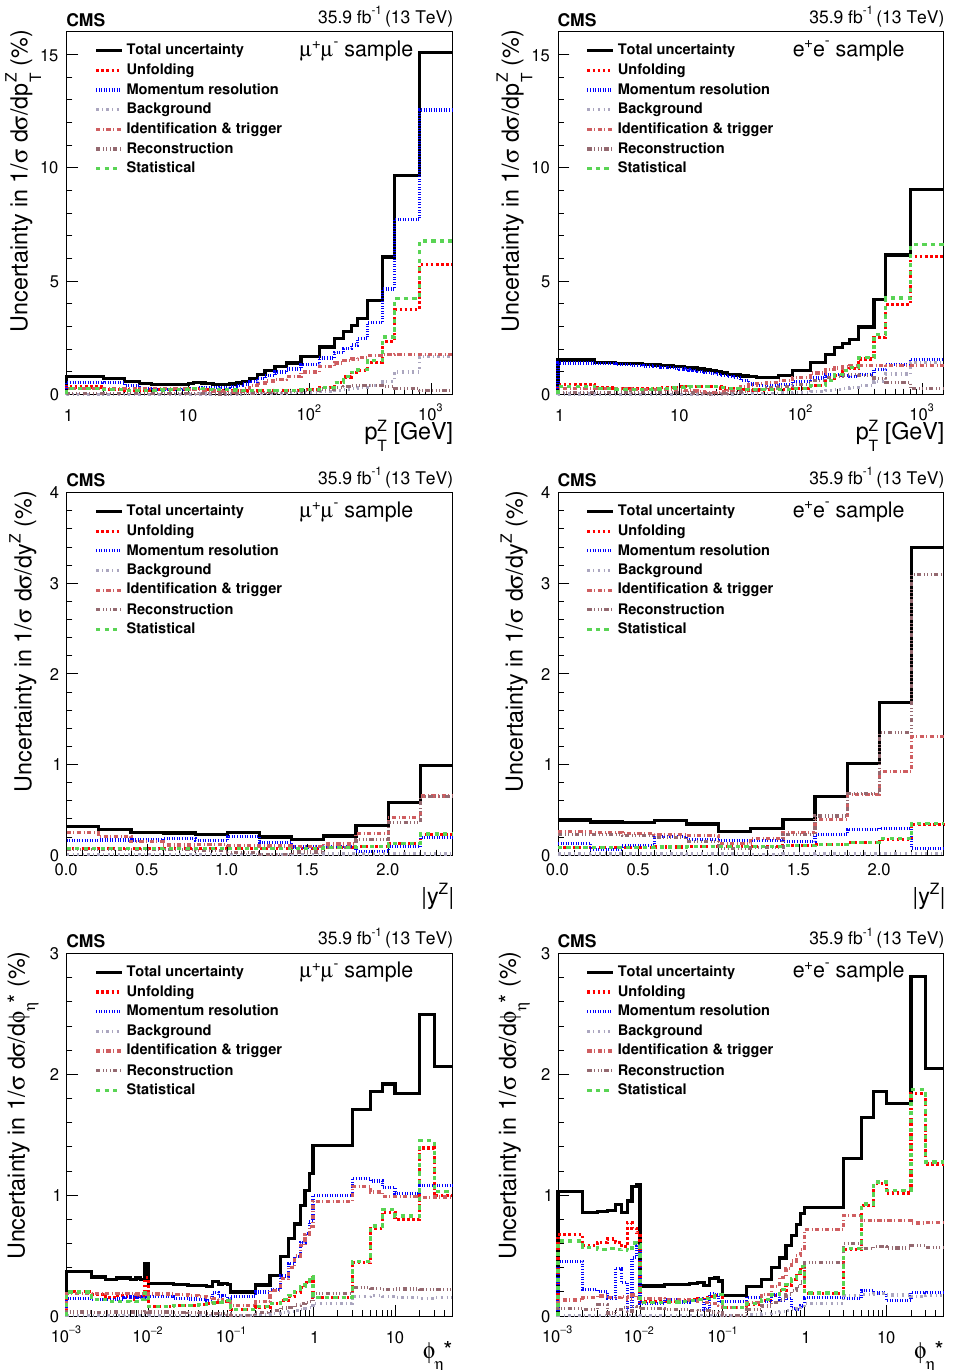
Figure 2 . The relative statistical and systematic uncertainties from various sources for the normal- ized cross section measurements in bins of p Z correspond to the dimuon (cid:12)nal state and the right plots correspond to the dielectron (cid:12)nal state.